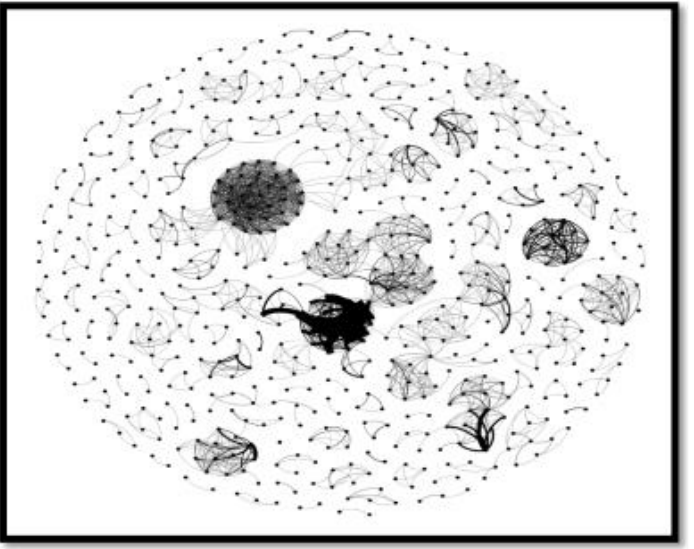
Figure 1. Force atlas layout (97 nodes and 1069 edges)